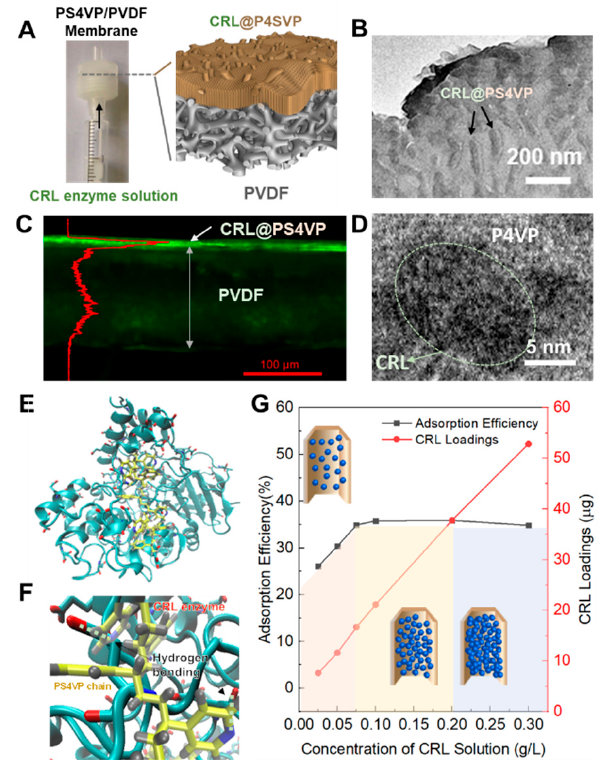
Figure 3. Loading CRL into the PS4VP/PVDF membrane. A ) Scheme of the loading process. B ) TEM images of CRL@PS4VP/PVDF. C ) EDX image of CRL@PS4VP/PVDF. The green shining part shows the existence of CRL. D ) Enlarged TEM images of the PS4VP area in CRL@PS4VP/PVDF (B, C, D: the initial concentration of CRL solution was 0.1 g/L). E and F ) Scheme of the interaction between CRL and PS4VP blocks (reseda: CRL, red: the glutamic and aspartic acids of CRL, yellow: PS4VP blocks, gray: the pyridines of PS4VP). G ) CRL adsorption efficiency and loading curves at different initial concentrations of CRL solutions.